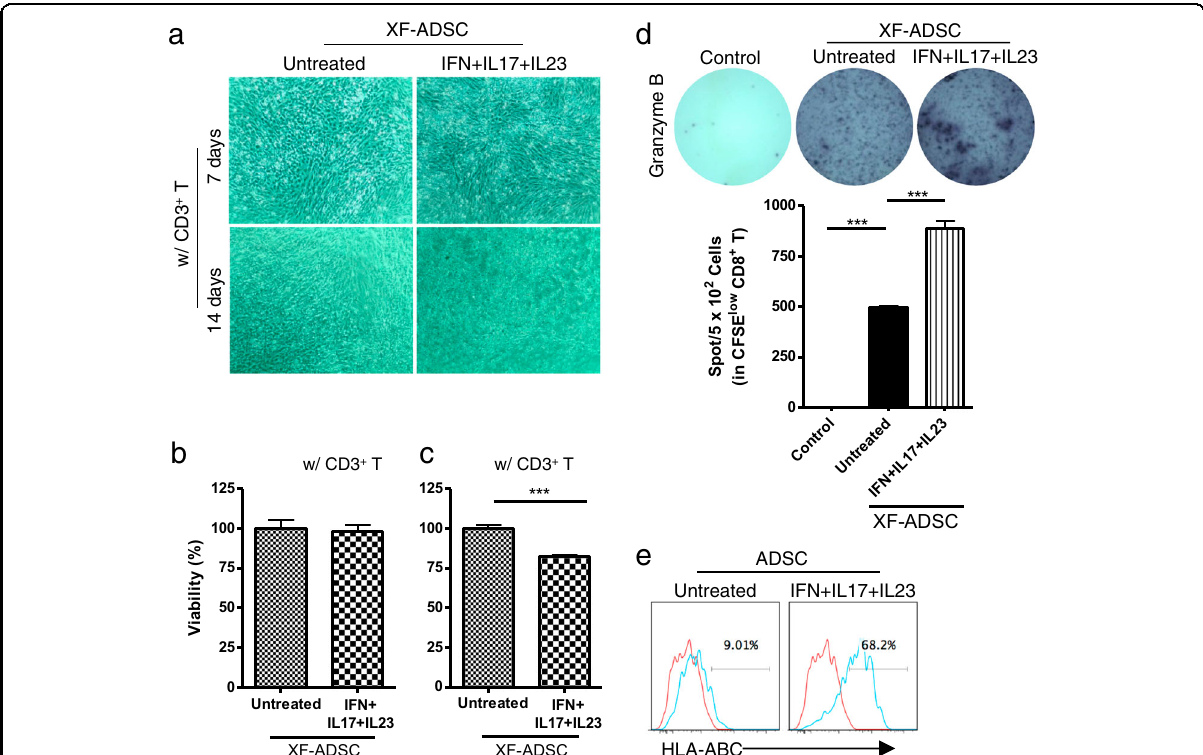
Fig. 3 Adipose-derived mesenchymal stem cells grown in xeno-free medium (XF-ADSCs) pretreated with proin fl ammatory cytokines induced recipient CD8 T cell-mediated cytotoxicity through granzyme B secretion. a XF-ADSCs pretreated with a combination of interferon- γ (IFN- γ ), interleukin (IL)-17, and IL-23 were subjected to allogeneic antigen stimulation for 7 or 14 days in xeno-free medium containing 5% autologous serum. The pretreated XF-ADSCs were reacted with each T-cell type, and the cell viability was evaluated in comparison with that of untreated XF- ADSCs. b Graphical representation of XF-ADSC viability after 7 days corresponding to ( a ) ( n = 6 for each sample). c Graphical representation of XF- ADSC viability after 14 days corresponding to ( a ) ( n = 12 for each sample). d Spots of granzyme B secreted by CD8 T cells were analyzed by enzyme- linked immunospot (ELISPOT) analysis ( n = 4 for each sample). e Representative analysis of human leukocyte antigen (HLA)-ABC expression levels in untreated ADSCs or IFN- γ -, IL-17-, and IL-23-treated ADSCs by fl ow cytometry; *** p <